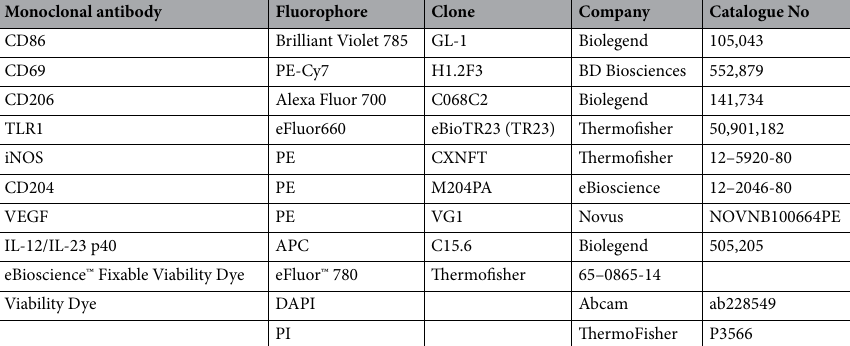
Table 1. Reagents used for flow cytometry